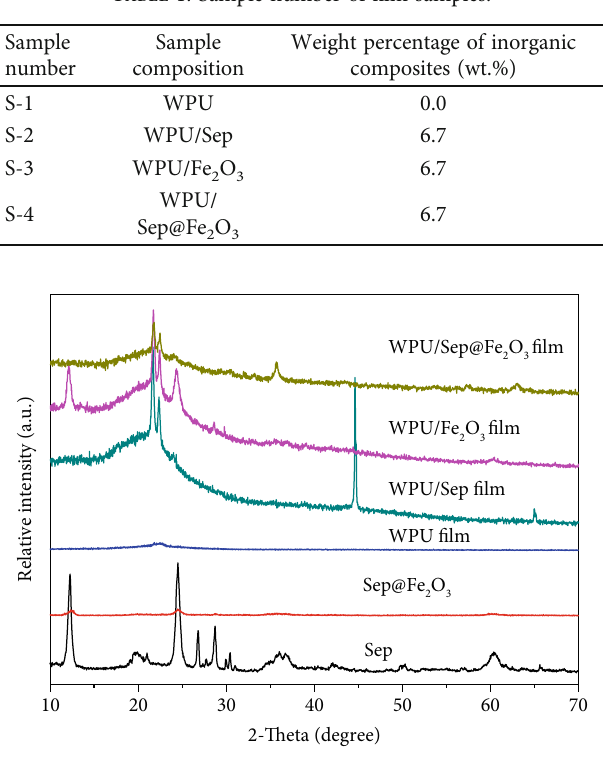
Figure 2: XRD curve of Sep samples and WPU composite fi